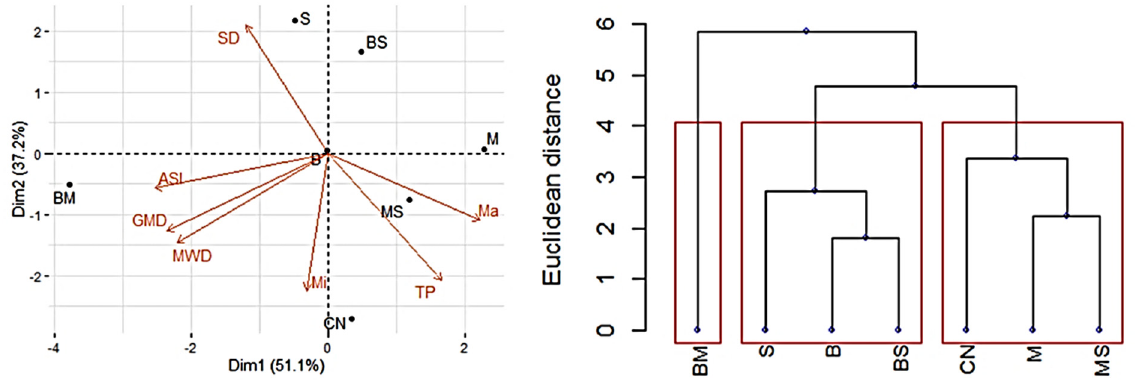
Figure 5. Principal components analysis and cluster analysis of cover crops and Cerrado native area (CN) (0.3–0.4 m soil depth). B = Brachiaria, M = Pearl millet, S = Sunn hemp; BM = B + M; BS = B + S; MS = M + S; CN = Cerrado native. SD = soil bulk density; Ma = soil macroporosity; Mi = Soil microporosity; TP = Soil total porosity; MWD = Mean weight diameter; GMD = Geometric mean diameter; ASI = Aggregate stability index.